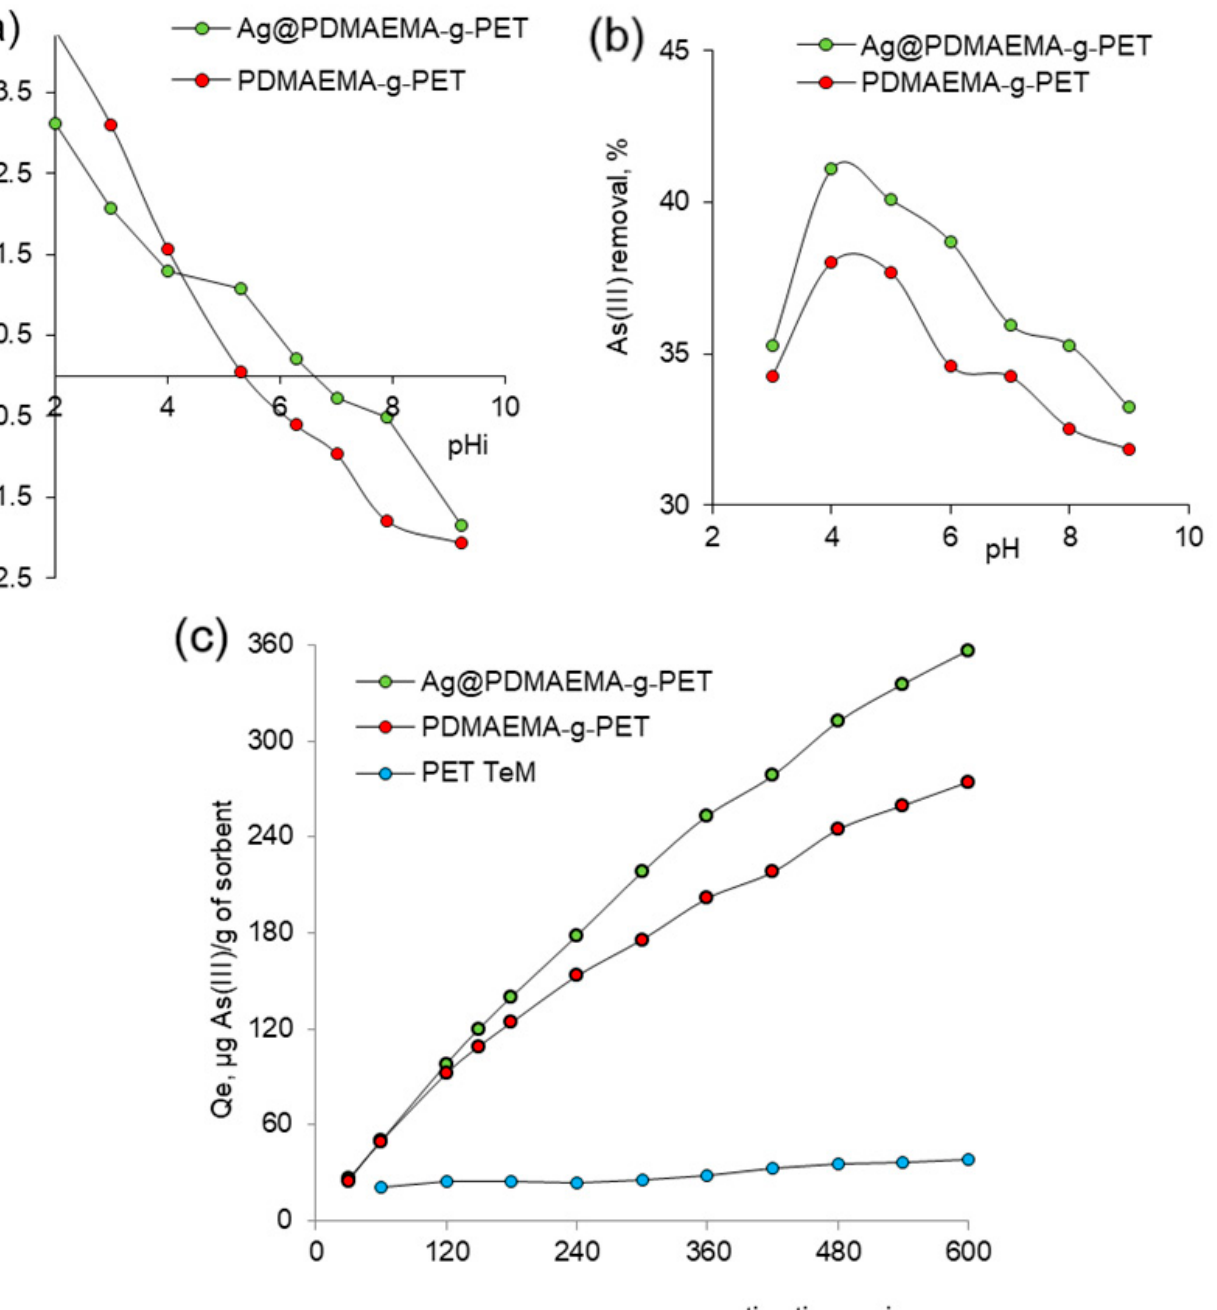
Figure 8. Point zero charge (pH PZC ) plot ( a ), effect of pH on As(III) removal (contact time: 300 min, As(III) concentration: 50 ppm) ( b ), effect of contact time on As(III adsorption capacity (pH: 4.0, As(III) concentration: 50 ppm) ( c